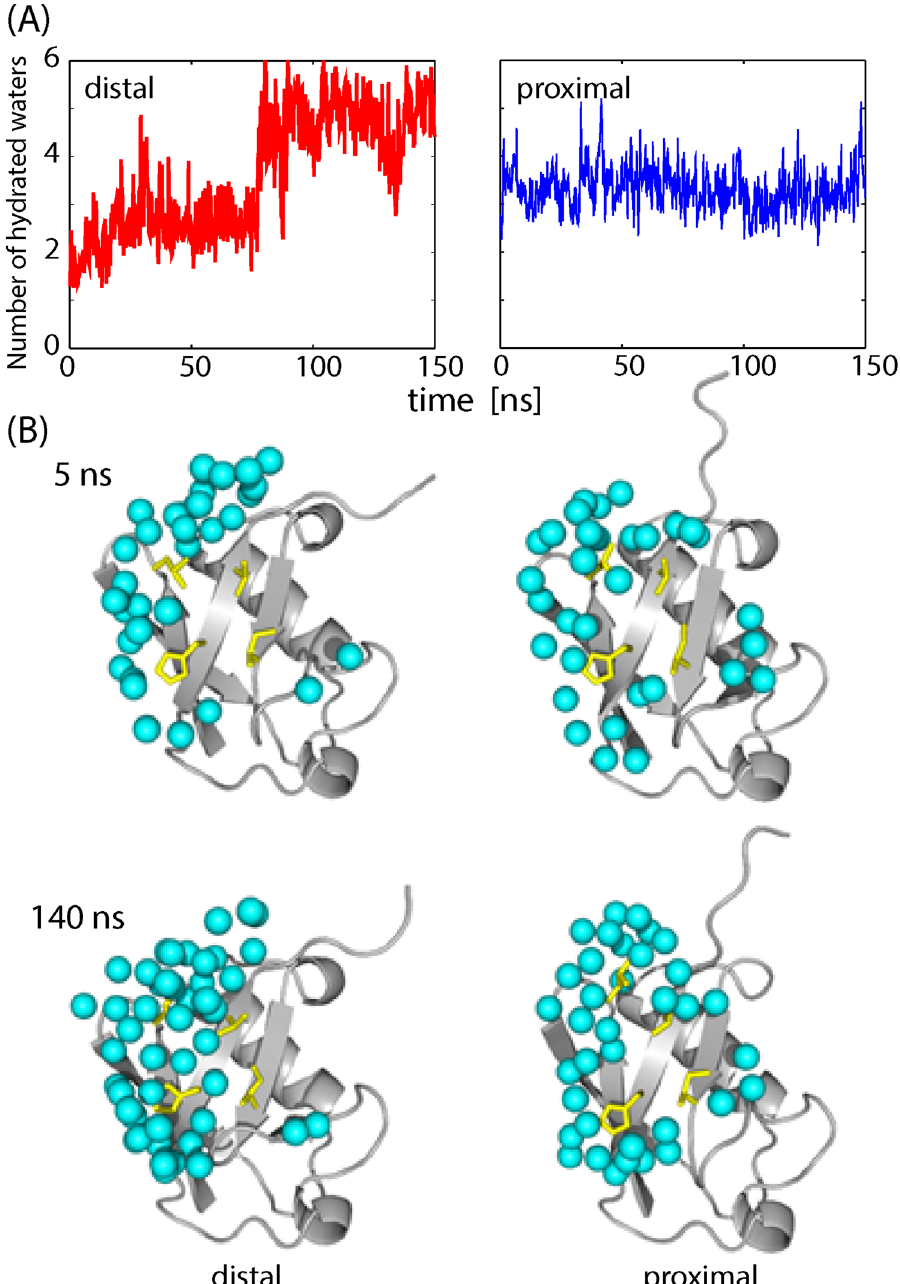
Figure 4. Hydration of the interface between di-Ub and TAB2 NZF. ( A ) Number of hydrated water molecules found on the interface (waters within 4 Å of the protein interface). The left and right figures are for the distal Ub and proximal Ub, respectively. ( B ) The snapshots of interfacial waters for the distal Ub (left) and proximal Ub (right) after 5 ns (upper) and 140 ns (lower) during MD simulation. The water molecules are depicted by cyan spheres and the four residues of the I44 patch (L8, I44, H68, and V70) are drawn as yellow